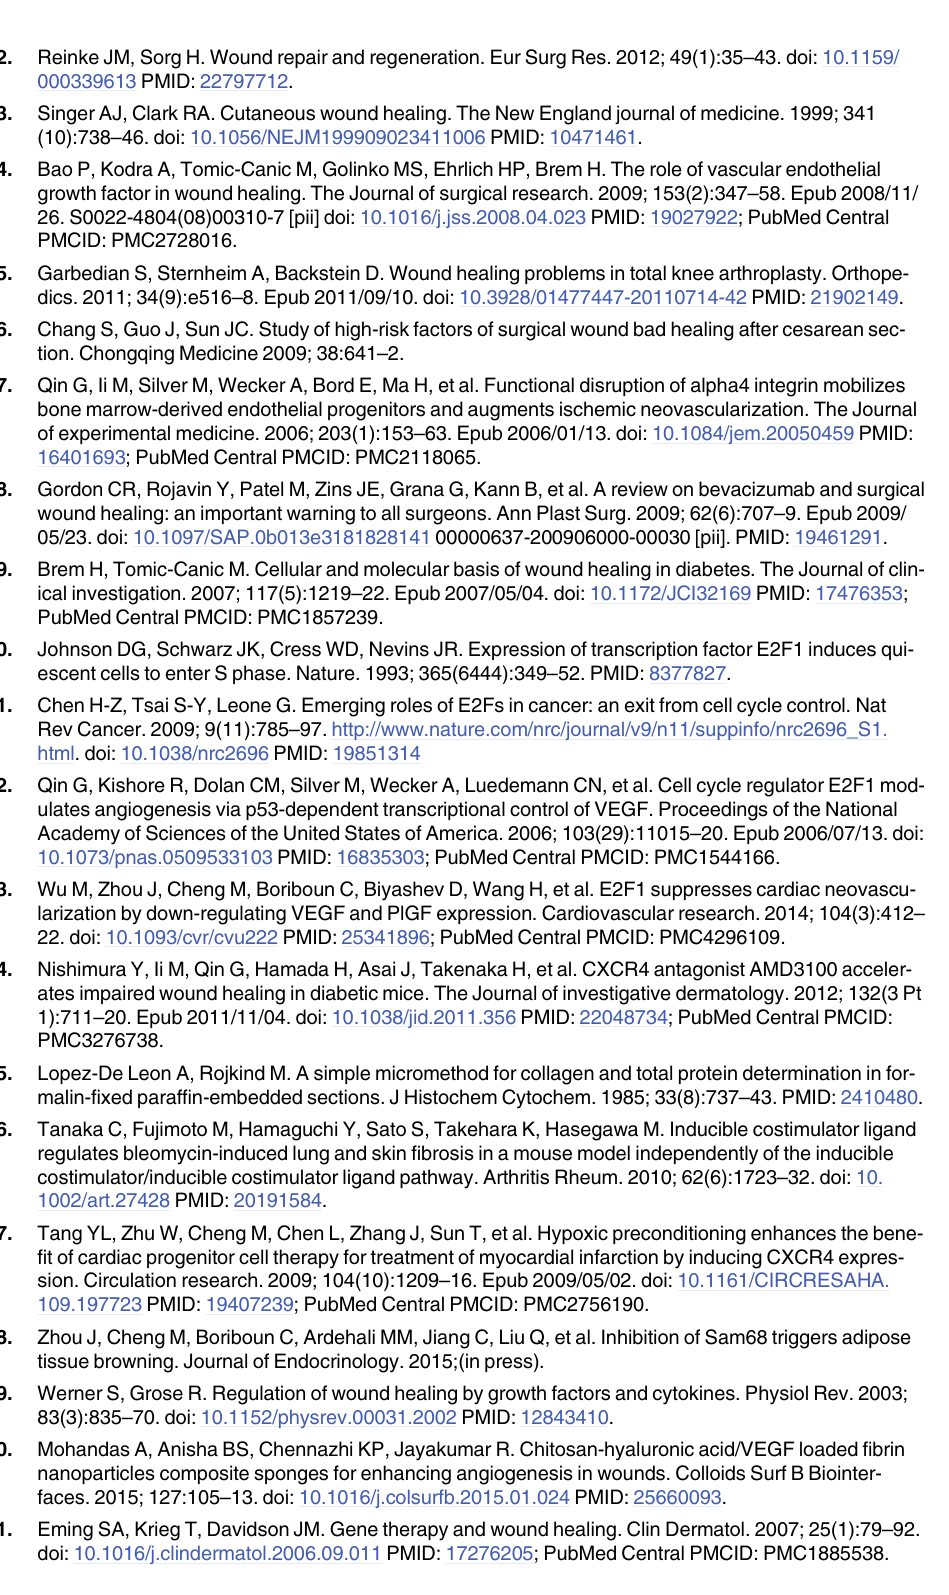
PLOS ONE | DOI:10.1371/journal.pone.0160411 August 4,